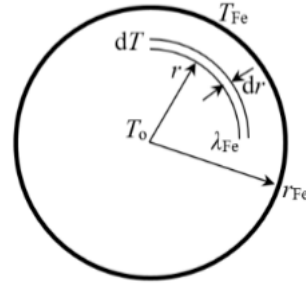
Figure 7. Calculating the temperature in the steel core axis.